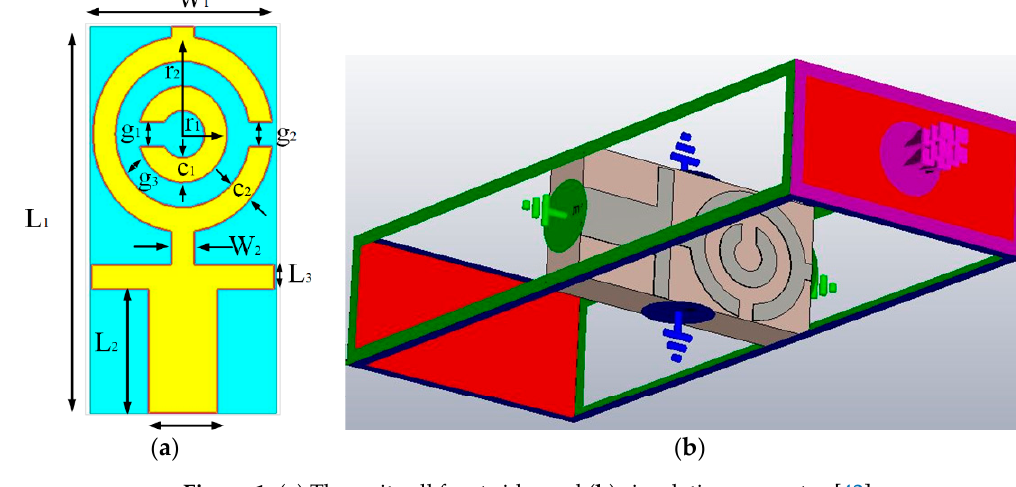
Figure 1. ( a ) The unit cell front side; and ( b ) simulation geometry [42]. Table 1. The design parameters of the unit